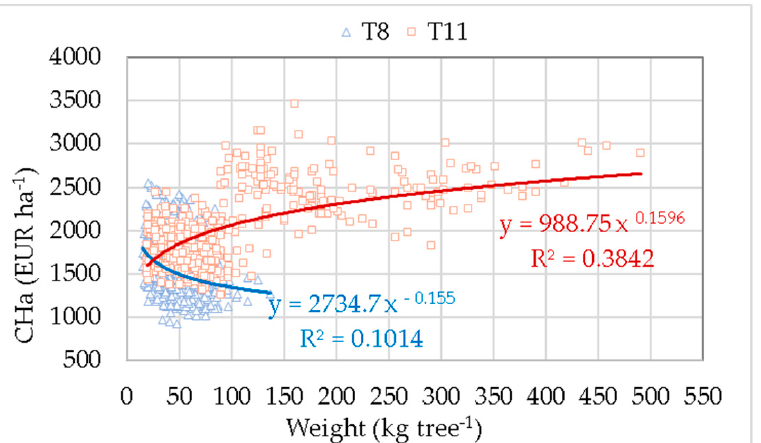
Figure 10. Cost per hectare ( CHa ) estimation models in relation to the weight of the tree for plantations